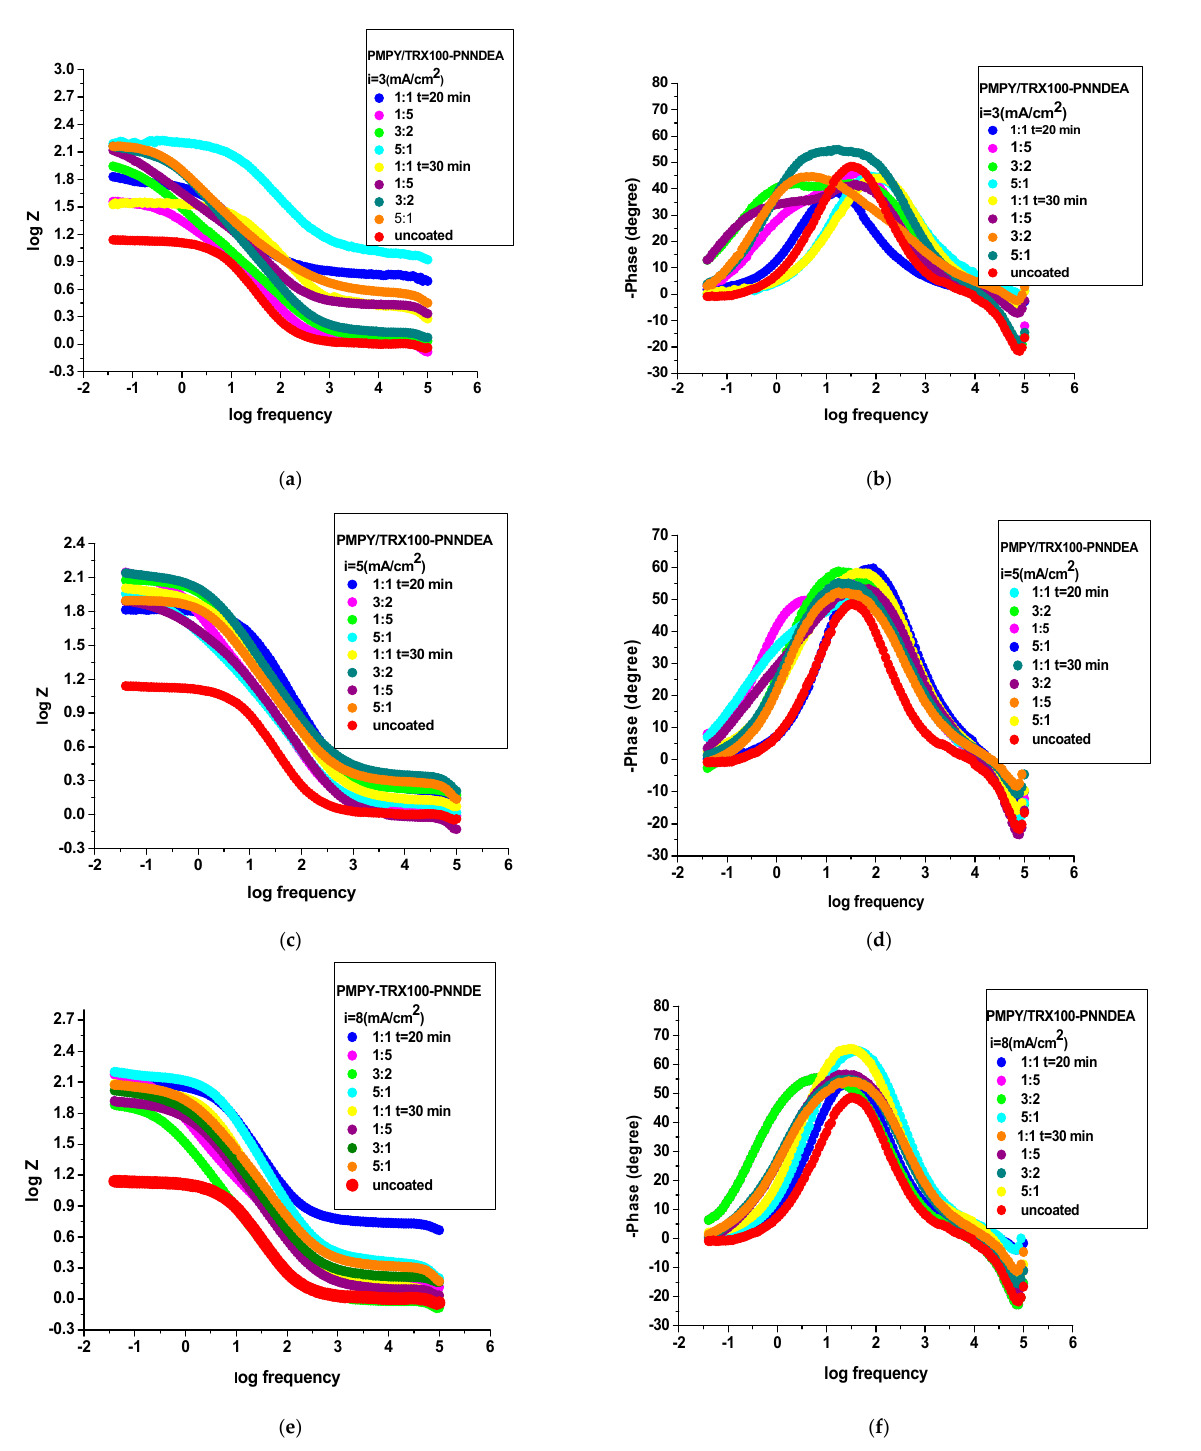
Figure 10. Bode plots for uncoated and PNMPY-TRX100/PNNDEA-coated of OL 37 electrodes by galvanostatic method at 3mA/cm 2 for 20min ( a ) and 30min ( b ), at 5mA/cm 2 for 20min ( c ) and 30min ( d ), at 8mA/cm 2 for 20min ( e ) and 30min ( f ) at varied molar ratios for PNMPY-TRX100 and PNNDEA.